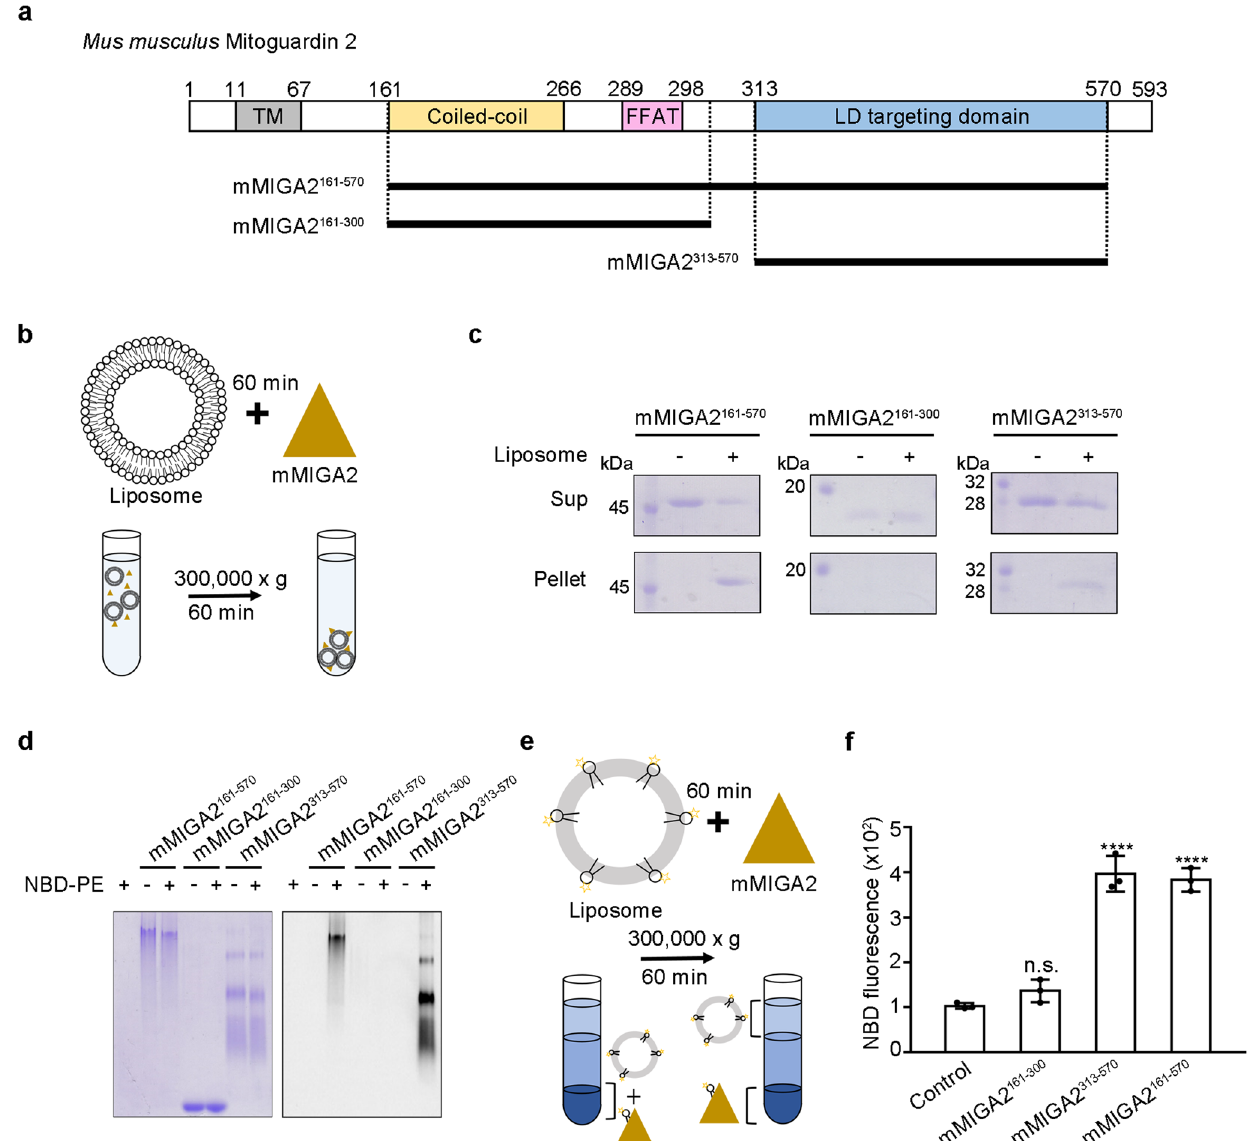
Fig. 1 MIGA2 directly binds to phospholipids. a Diagram showing the domain structure of Mus musculus MIGA2. From the N-terminus, the MIGA2 has a transmembrane domain (TM), Coiled-coil domain, FFAT motif, and LD targeting domain. b Schematic diagram of the liposome sedimentation assay. The mMIGA2 fragments were incubated with liposomes for 60 min and separated by centrifugation. c Figure showing the results of the liposome-binding assay performed as described in b . Supernatant (Sup) and precipitant fractions (Pellet) were analyzed by 12% SDS-PAGE and Coomassie blue staining ( N = 2 independent experiments). d The fl uorescence lipid-binding assay. The puri fi ed mMIGA2 proteins were incubated with NBD-PE and subjected to 10% Clear Native-PAGE (CN-PAGE) ( N = 2 independent experiments). Coomassie staining (left) and fl uorescent detection (right). e Diagram showing the in vitro lipid extraction assay. Liposomes containing NBD-PE were incubated with the mMIGA2 for 60 min. The mixtures were separated by centrifugation and precipitated fractions were analyzed by a fl uorescence measurement. f Bar graph showing the results of lipid extraction by mMIGA2 using experiments performed as described in e . Lipid extraction activity was compared to that of the control using one-way ANOVA ( N = 3 independent experiments; individual data point shown as dots, bars show mean ± SD). **** p < 0.0001 (mMIGA2 161 – 570 and mMIGA2 313 – 570 ). Source data are provided in a Source data fi 60.83% sequence identity to human and mouse MIGA2, respec- tively). We obtained crystals of the zebra fi sh Miga2 LD targeting domain (residues 310 – 568), which we refer to as zMiga2. zMiga2 shares 74.9% and 76.1% sequence identity to human and mouse LD targeting domains, respectively. A crystal of zMiga2 solved by single-wavelength anomalous dispersion (SAD) using selenium as an anomalous scatterer (Supplementary Fig. 2 and Supplementary Table 1).